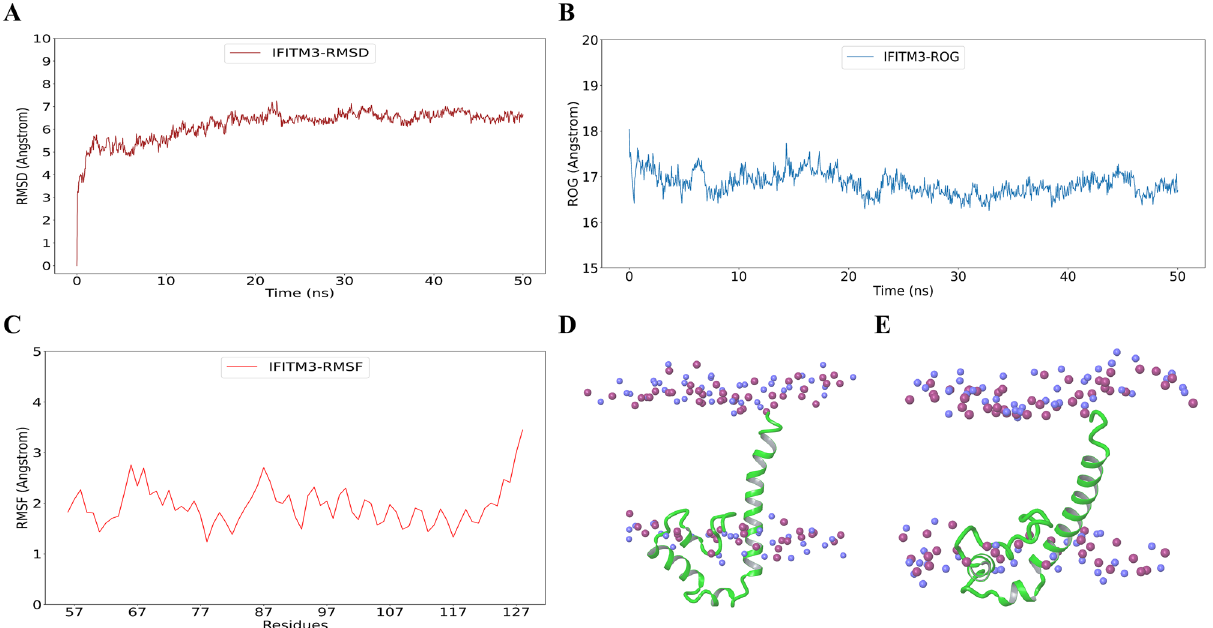
Figure 2. MD simulation results of IFITM3 model ( A ) RMSD of IFITM3 with respect to 0th ns ( B ) RMSF of residues across simulation time ( C ) Radius of gyration across simulation time ( D ) IFITM3 model at 0th ns ( E ) IFITM3 model at 50th ns. Blue and magenta spheres represent nitrogen and phosphorus of POPC